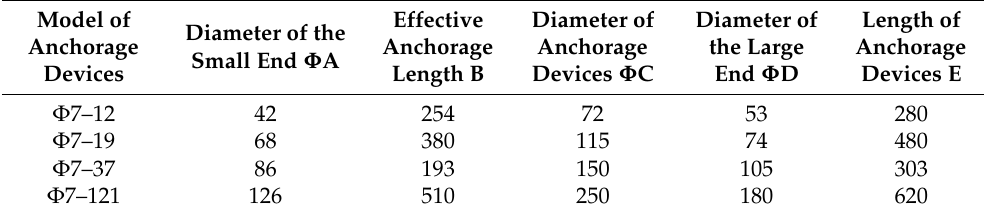
Figure 5. Φ 7–37 Composite anchorage device. Table 2. Parameters of anchorage devices.